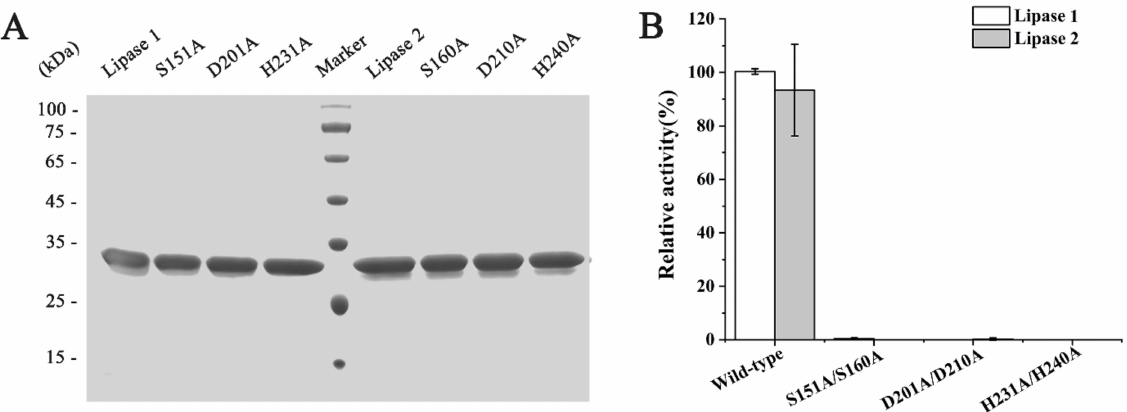
Figure 7. Activity assays of wild type and different mutants of Lipase 1 and Lipase 2. ( A ) Purification detection of wild type and corresponding mutants of Lipase 1 and Lipase 2 through SDS-PAGE. ( B ) Activity detection of wild type and corresponding mutants of Lipase 1 and Lipase 2, in which the activities of wild type Lipase 1 and Lipase 2 were defined as 100%.